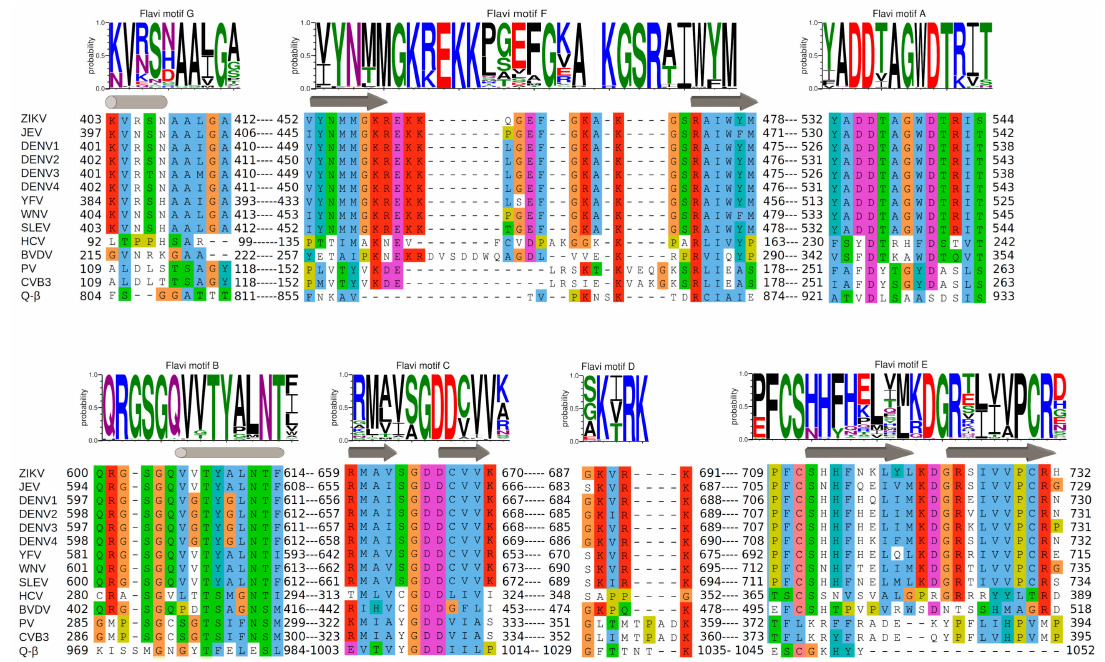
Figure 4. Conservation of sequence and structural motifs A to G within Flavivirus RdRps (Weblogo) and selected positive-strand RNA virus RdRps (alignments). Motifs are given as they appear; N- to C-terminus in the primary sequence of the RdRps: G, F, A, B, C, D, E. Selected sequences of NP_722465), DENV2 (PDB ID: 5K5M), DENV3 (PDB ID: 5CCV), DENV4 (NCBI NP_740325), YFV (NCBI NP_041726), WNV (NCBI NP_041724), St. Louis encephalitis virus (SLEV, NCBI YP_001008348), HCV (PDB ID: 4WTA), bovine viral diarrhea virus (BVDV, PDB ID: 1S49), PV (PDB ID: 3OL6), Coxsackie virus B3 (CVB3, PDB ID: 4ZPD), and bacteriophage Q- β (PDB ID: 3AVT). The alignment was